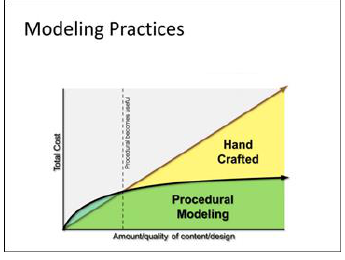
Figure 9. Grammar-based Modelling